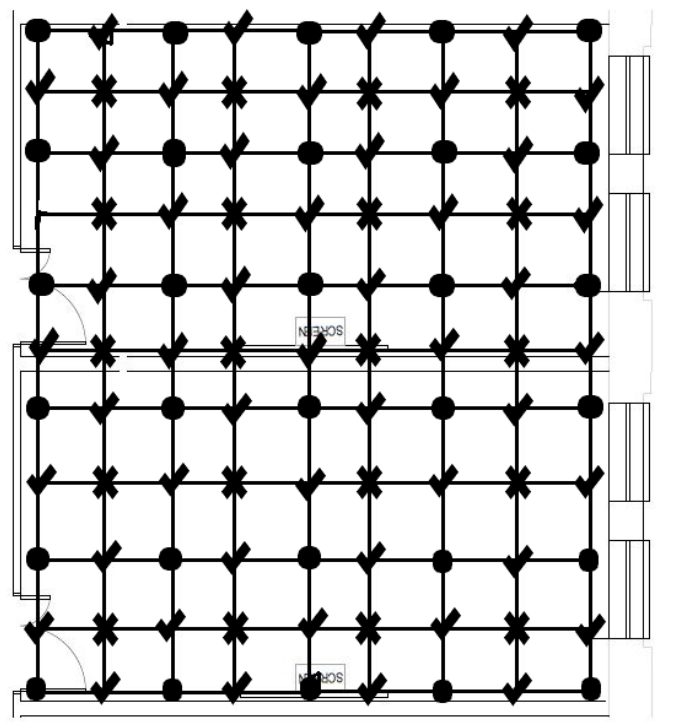
Figure 2. Reference Points (RPs) and Test Points (TPs) for symmetric and asymmetric